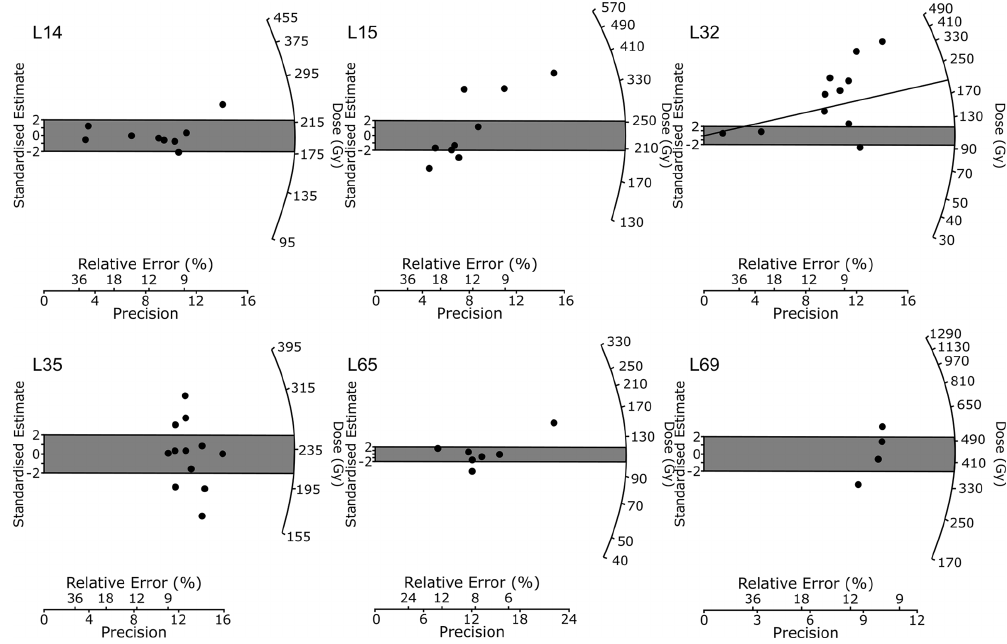
Figure B2. Radial plots showing the dose distributions of accepted aliquots for all fine-grained samples, as well as the calculated central age (shaded area). In the case of L32 (A0115), the shaded area corresponds to the minimum age calculated using the MAM, and the line corresponds to the equivalent dose, which would yield the expected age according to a preliminary core age model.